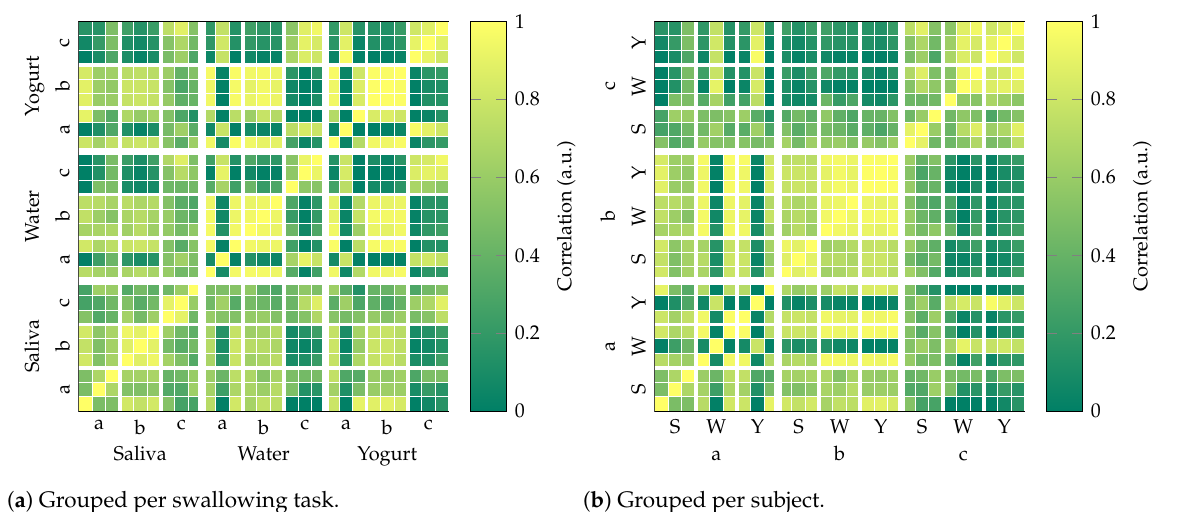
Figure 9. Normalized cross-correlation for each of the 27 trials grouped by different categories.